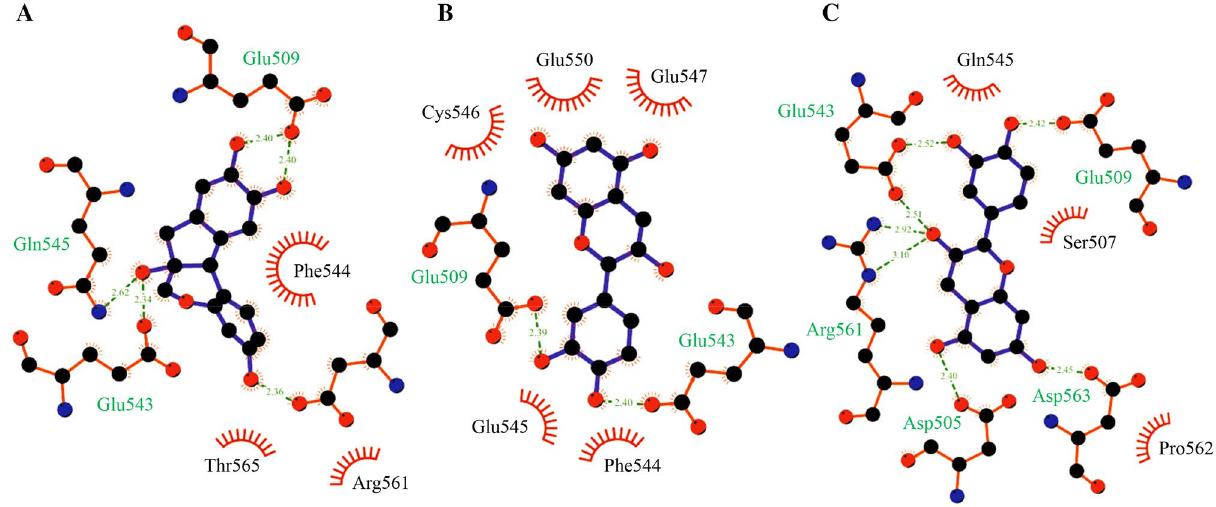
Figure 5. Hydrophobic interactions and hydrogen bonding of bound SRCR5 forms with three natural compounds: ( A ) SRCR5-brazilin, ( B ) SRCR5-catechin, and ( C ) SRCR5-epicatechin complexes. Complexes E VdW E Elec E Polar E Non-polar Binding